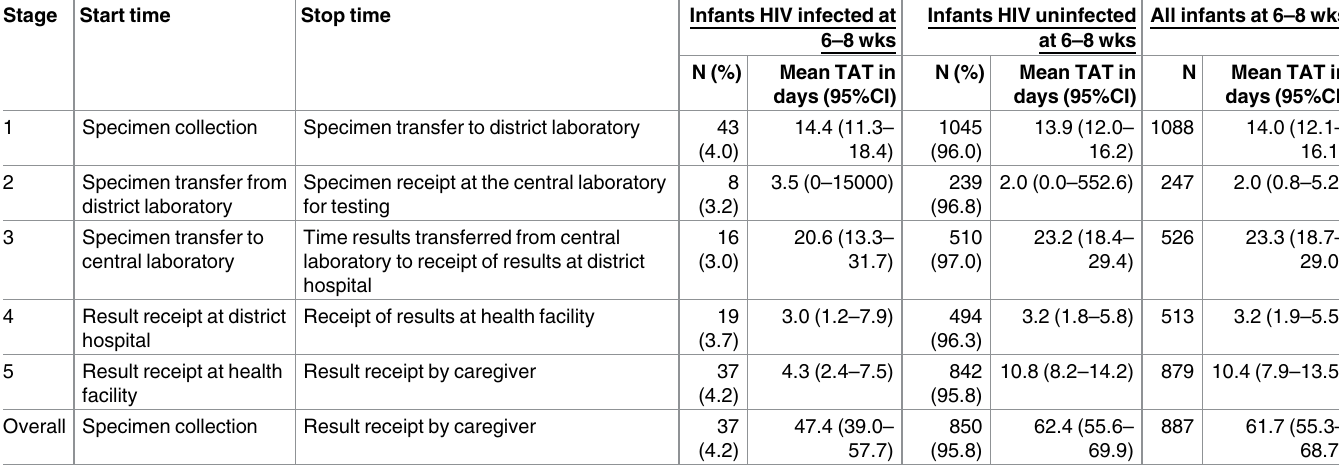
Table 2. Turnaround time (TAT) for the stages in the EID cascade calculated from linear mixed models. Stage Start time